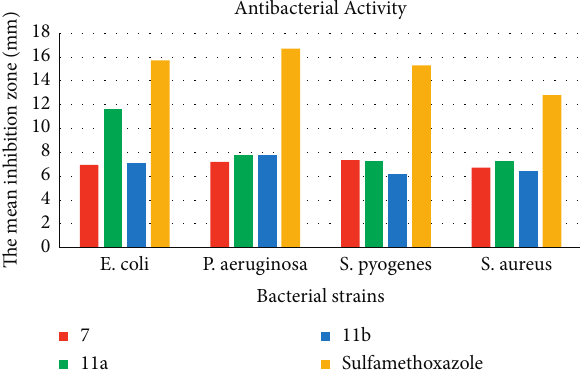
Figure 2: Mean inhibition zone of synthesized compounds in mm (mean ± SD) at 50mg/mL. Table 2: % radical scavenging activities of synthesized compounds and ascorbic acid. Conc. ( μ